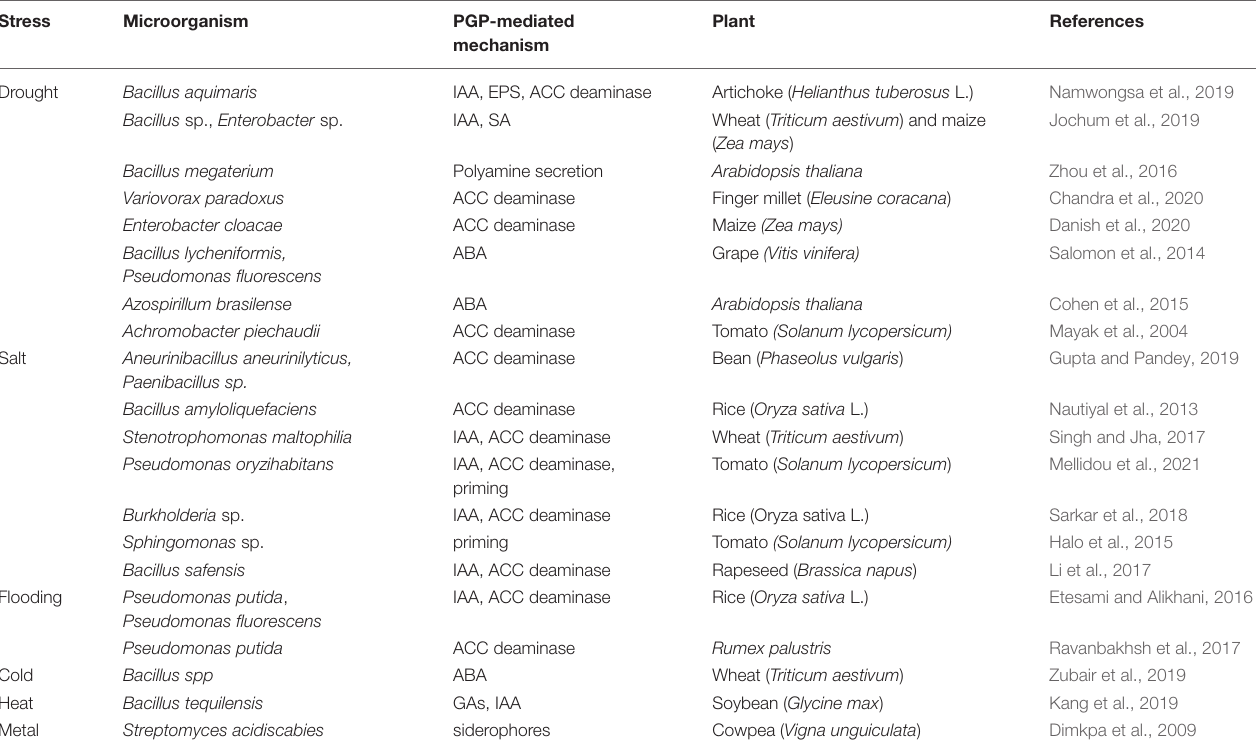
TABLE 1 | Selected PGPR that alleviate abiotic stresses and their mechanism of